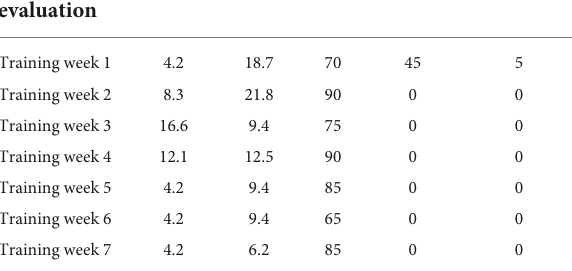
TABLE 8 Values in the POMS factors of Subject 4 after training.